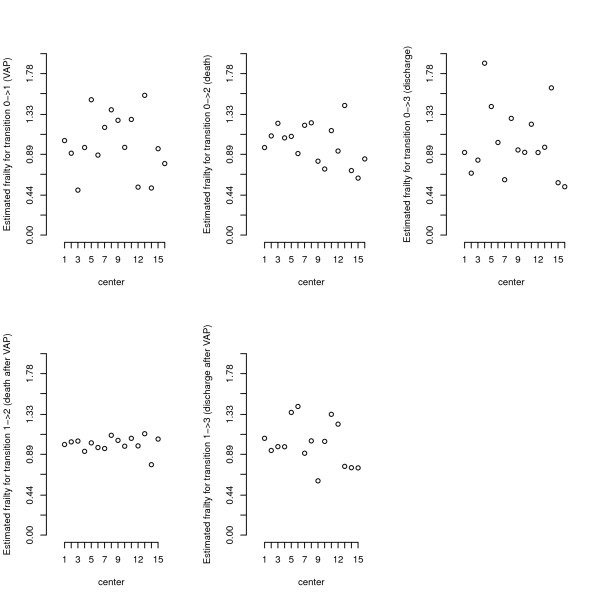
Random centre-specific effect as estimated by posterior distribution for the different transitions. The clusters have been ordered (ascending order) by the number of subjects in the cluster.